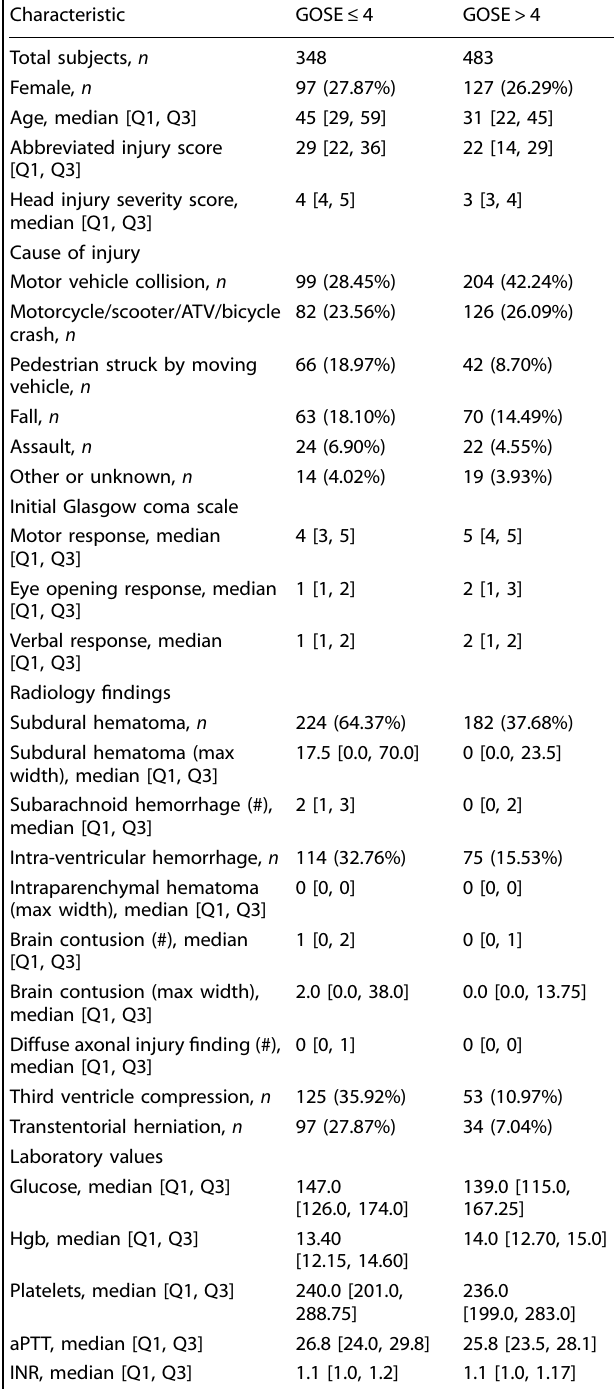
Table 1. Demographic and clinical characteristics of study